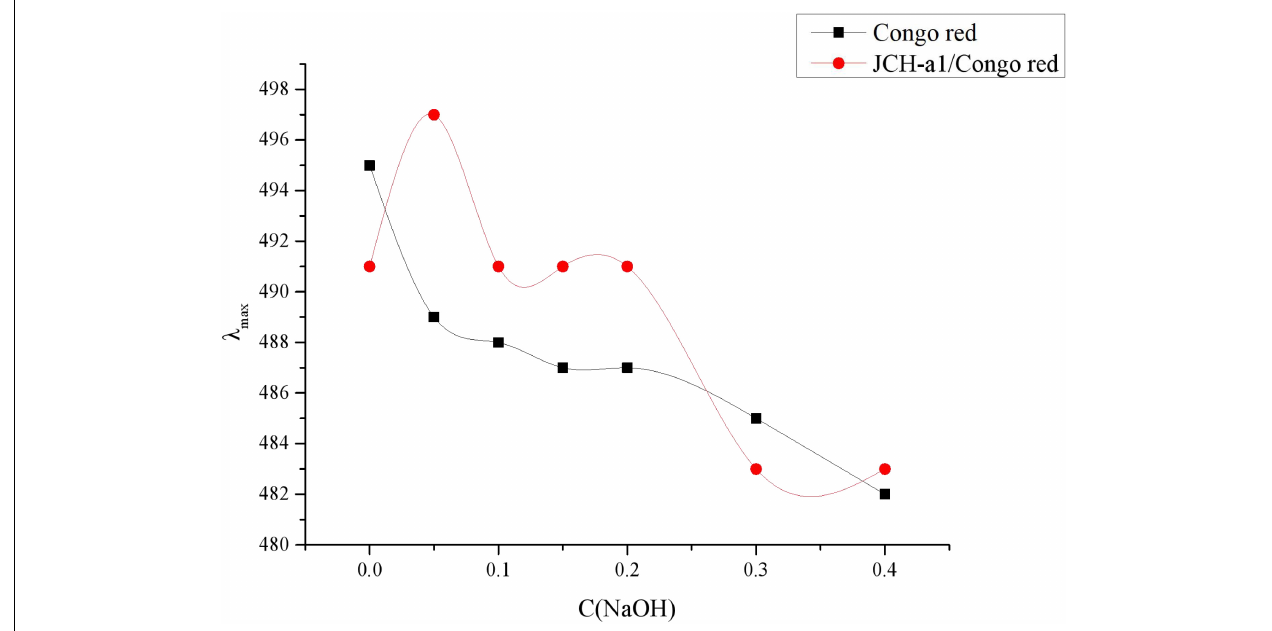
FIGURE 5 | Changes in the maximum absorption wavelength ( λ max ) of JCH-a1/Congo red complex with various NaOH